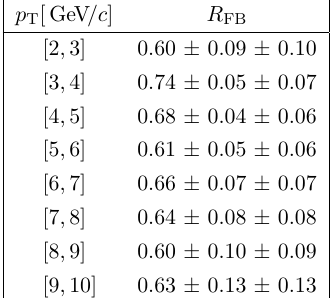
Table 4 . Double-di(cid:11)erential cross-section (in mb = ( GeV =c )) for prompt (cid:3) + of p T and y (cid:3) in p Pb forward and backward data. The (cid:12)rst uncertainty is statistical and the second is systematic.